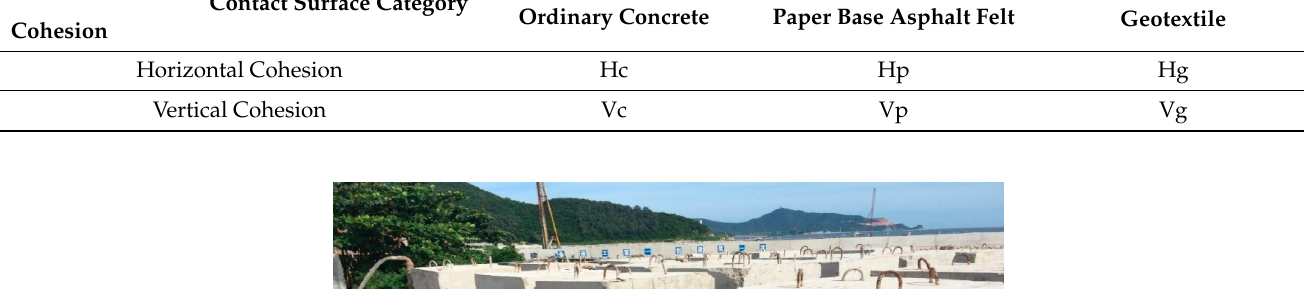
Figure 3. The pre-placed reaction frame. Table 1. Test block classification table.